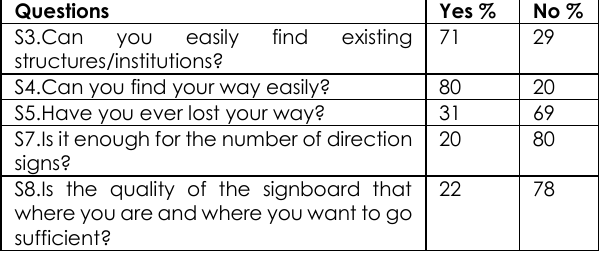
Table 2. Percentage (%) distribution of the participants’ data related to direction finding and direction.